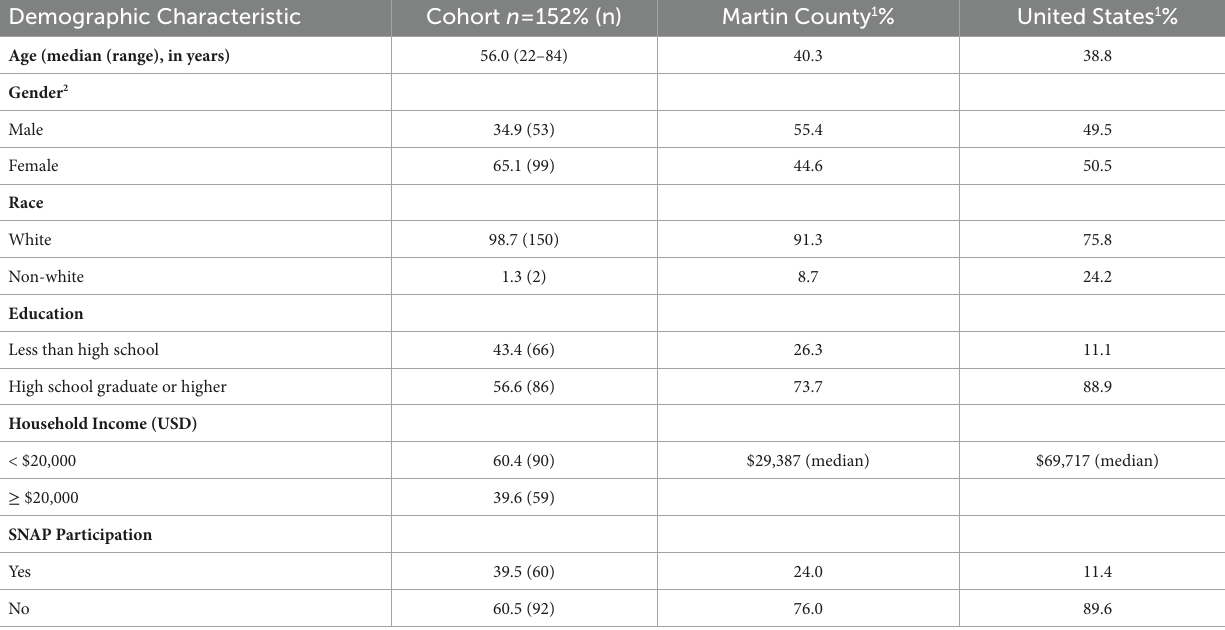
TABLE 2 Sociodemographic characteristics among the sampled cohort, compared to Martin County, KY, and the United States, 2019–2022. Demographic